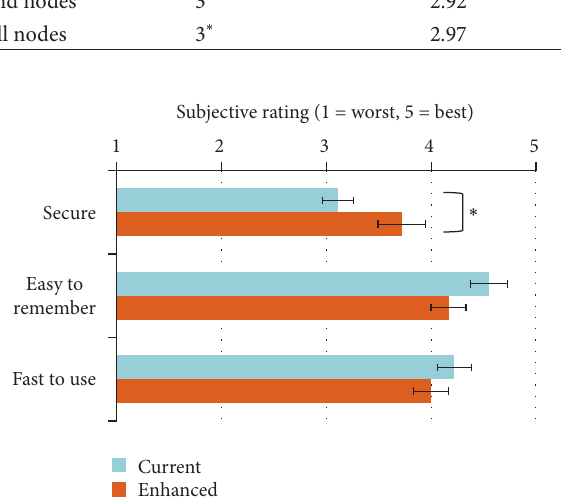
Figure 7: Mean subjective ratings for the user’s current and the enhanced lock mechanism. Error bars indicate standard error of mean. ∗ = significant difference 𝑝 < .05